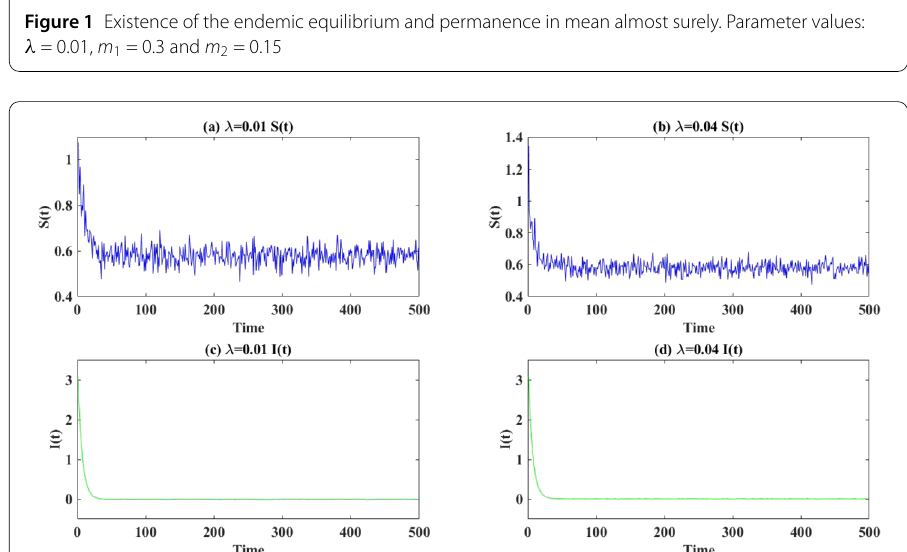
Figure 2 Examples of Theorem 3.2. The dynamics of system (43) are shown with parameter values as described in the text, and (left column) λ = 0.01, m 1 = 0.4 and m 2 = 0.25 (right column) λ = 0.04, m 1 = 0.5 and m 2 =